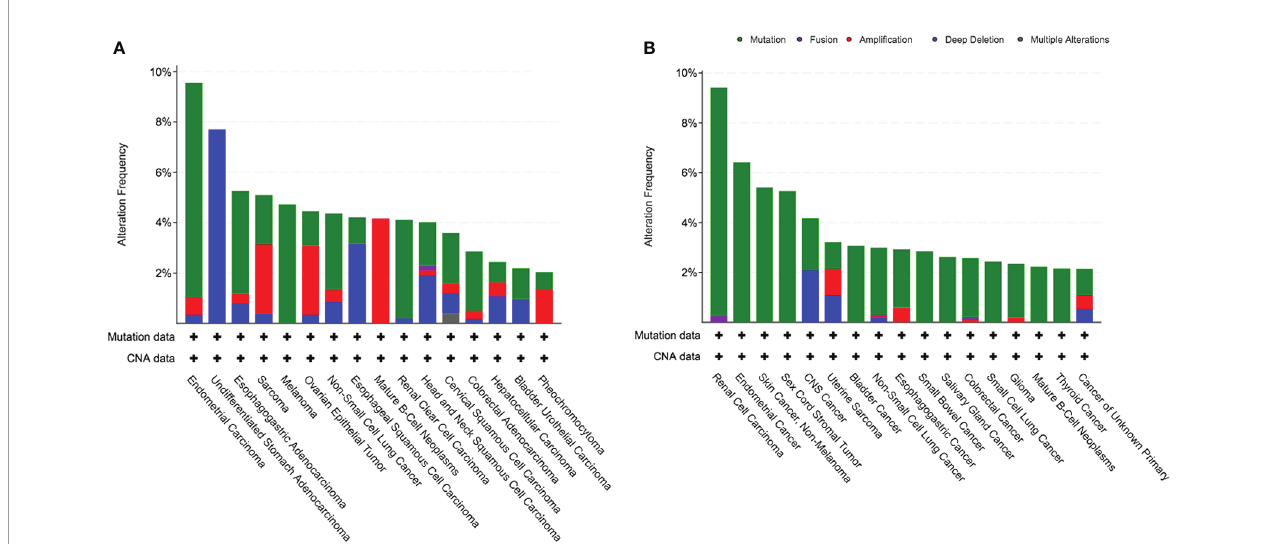
FIGURE 2 | Prevalence of KDM5C alterations in different cancers. (A) TCGA cohort; (B) MSK-IMPACT